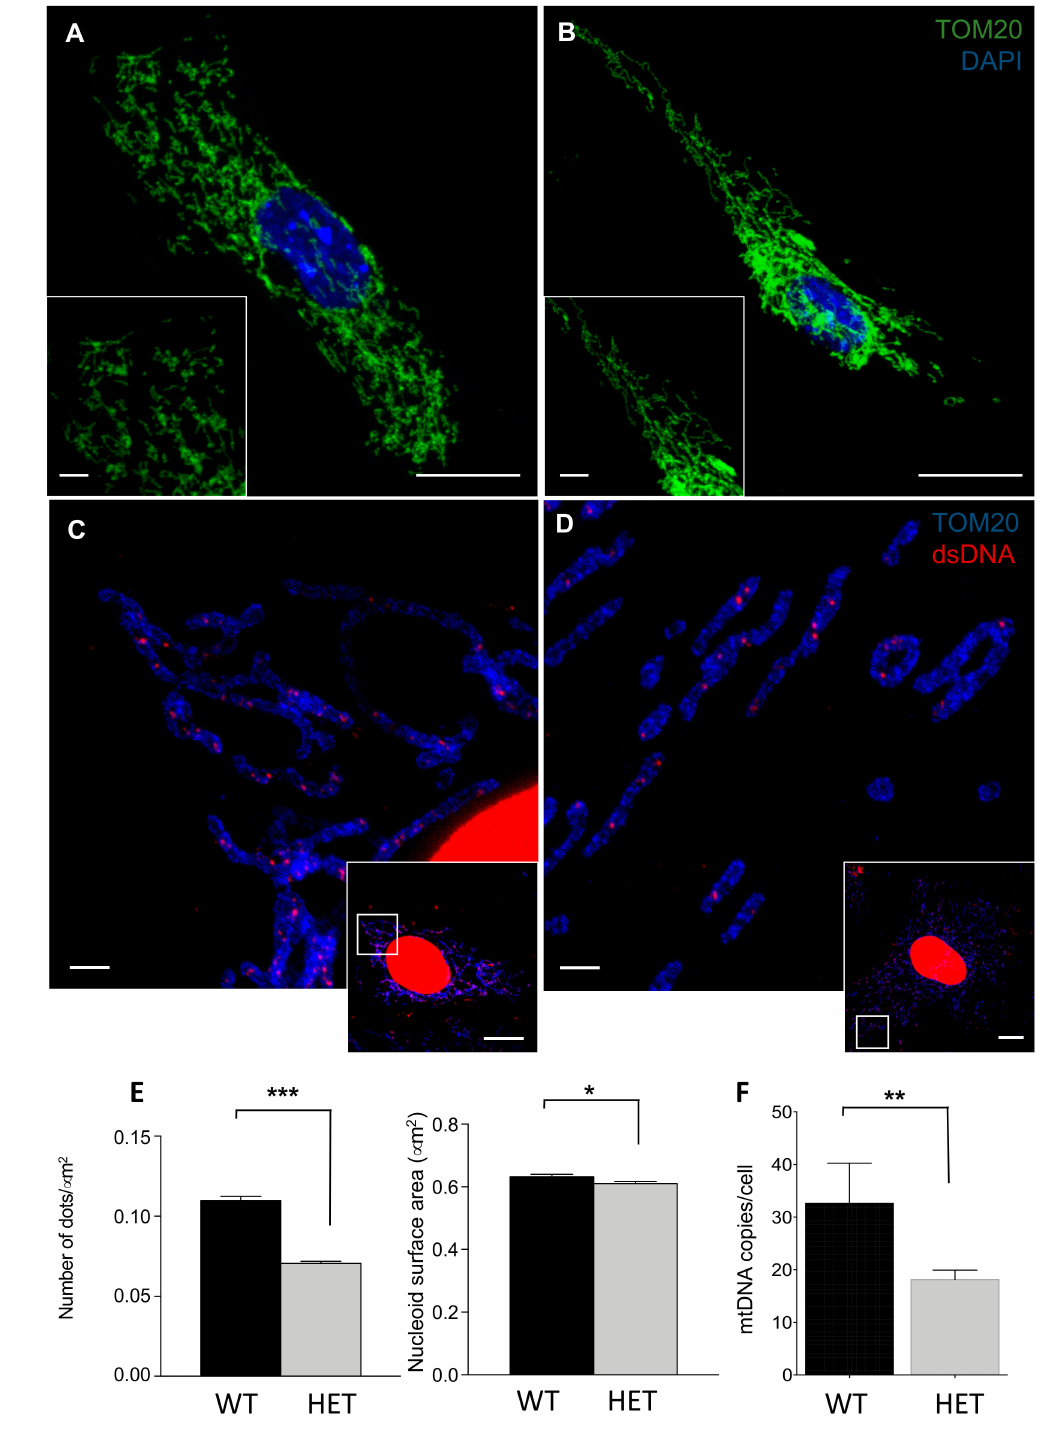
Figure 4. Imaging of mitochondrial and submitochondrial structures and mtDNA amount in embryonic fibroblasts (MEFs). ( A , B ) Confocal images of mitochondrial network from wt and het MEFs stained with anti-TOM20. A : wt; B : het. (Bars of larger panels are 1 µ m; bars of smaller panels: 10 µ m). ( C , D ) Stimulated emission depletion (STED0 images of mitochondrial DNA from wt and het MEFs stained with anti-TOM20 and anti-dsDNA. C : wt; D : het. (Bars of larger panels are 1 µ m; bars of smaller panels: 10 µ m). ( E ) Analysis of the number and the dimensions of nucleoids. ( F ) Mitochondrial DNA quantification of MEFs by droplet digital PCR. Data are expressed as mean ± SEM. * = p < 0.05, ** = p < 0.01, *** = p <